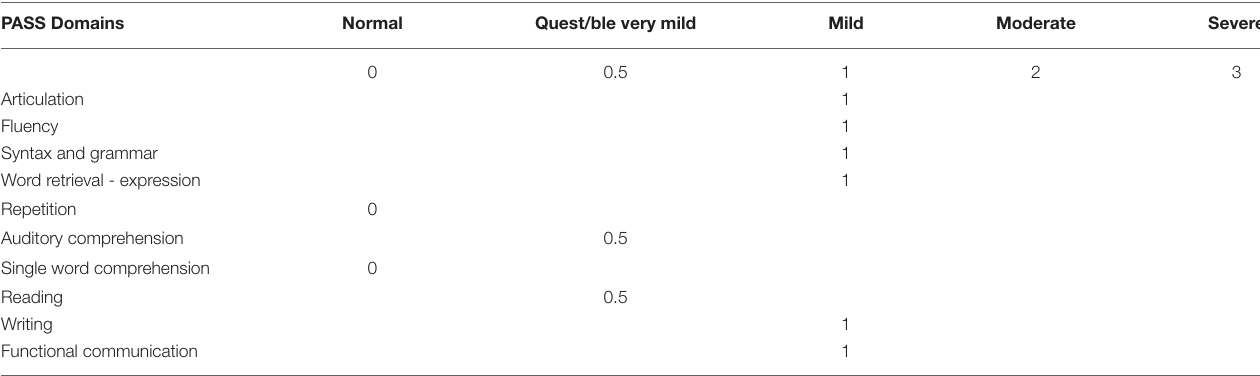
TABLE 2 | Consensus score on the Progressive Aphasia Severity Scale (PASS) at initial evaluation. PASS Domains